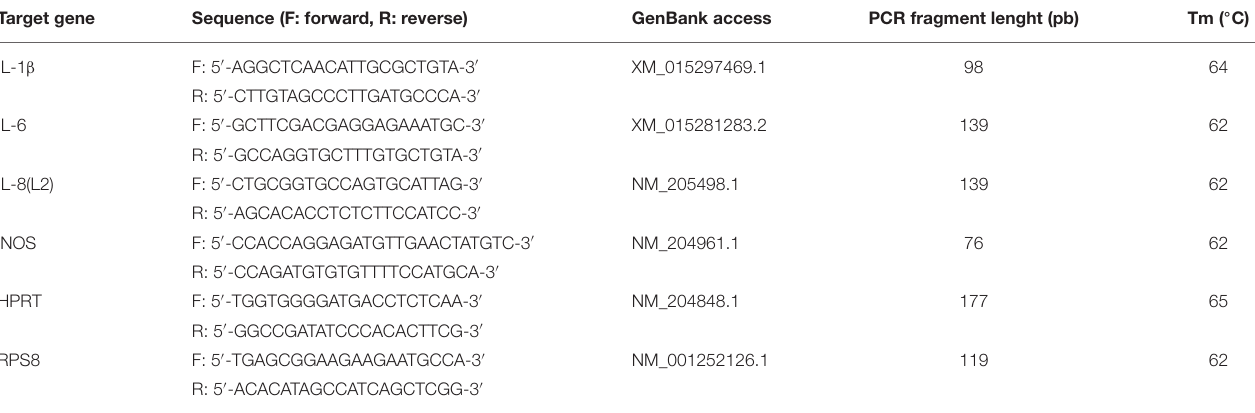
TABLE 2 | Primer sequences used in real-time PCR analyses. Target